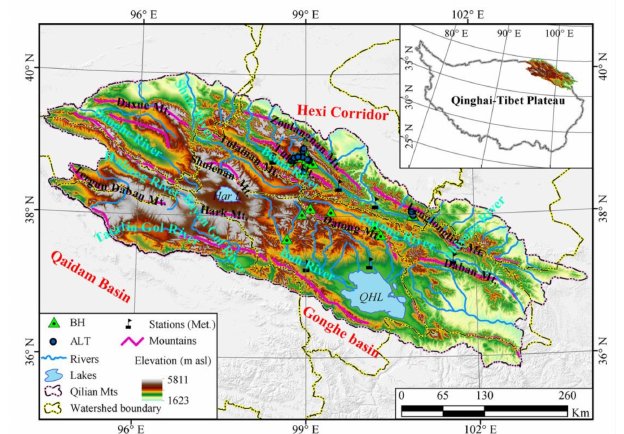
Figure 1. Geographical background of the Qilian Mountains. QHL and Har L denote the Qinghai Lake and Hala Lake, respectively. BH and ALT denote the boreholes and active layer thickness sites used to validate the model in this study, respectively, which were mainly collected from documents